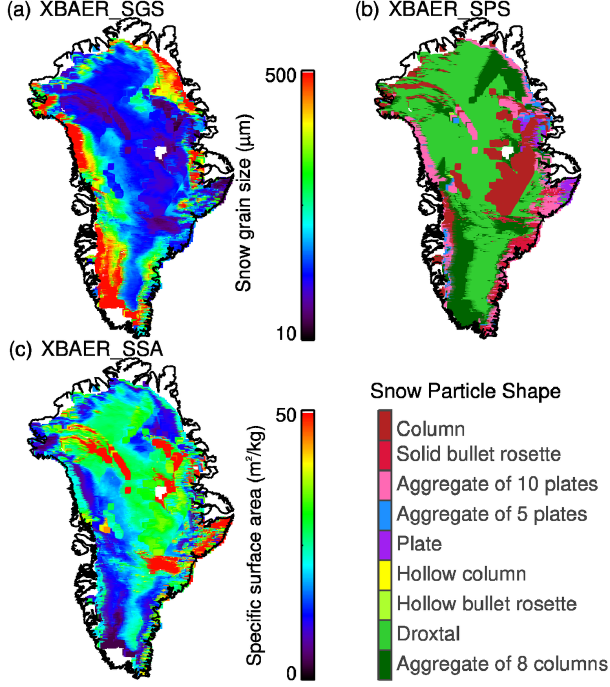
Figure 5. XBAER-derived SGS, SPS and SSA over Greenland for the same scenario as in Fig.